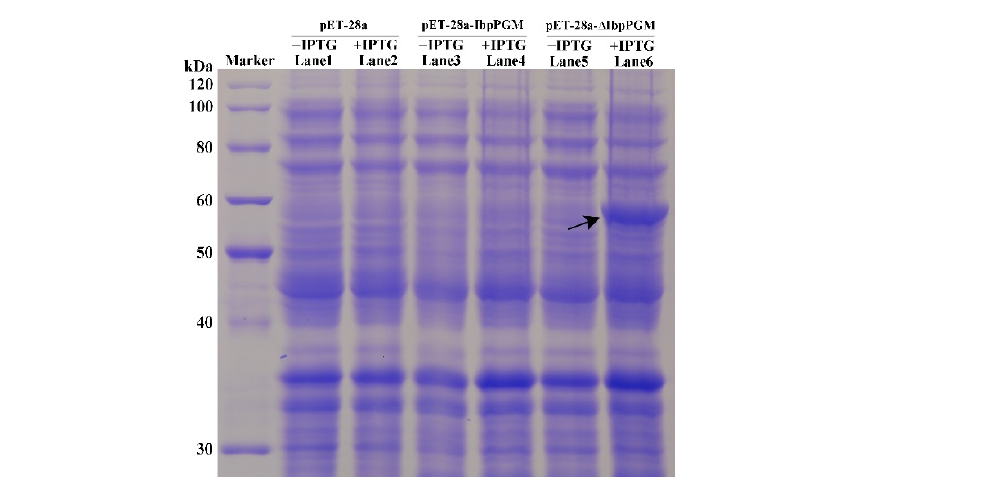
Figure 4. Prokaryotic expression of IbpPGM in E. coli. The arrow indicates the induced protein of IbpPGM without the chloroplast transit peptide.